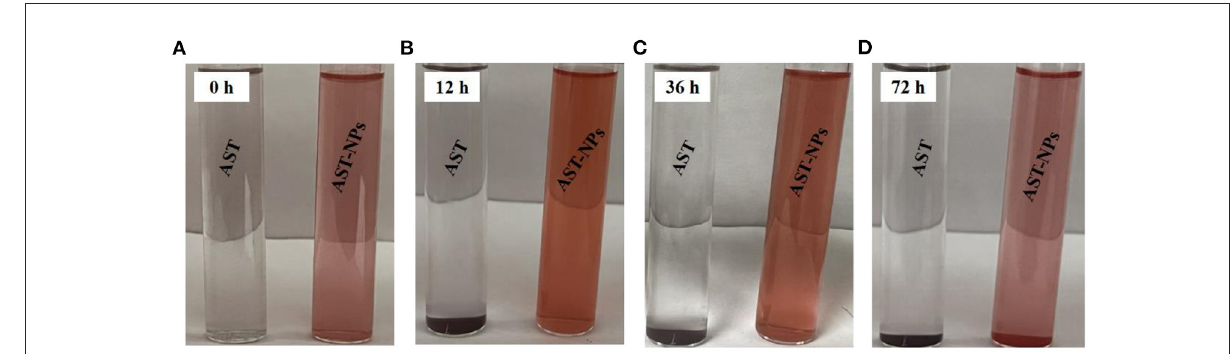
FIGURE5 The visual appearances of free AST and AST-NPs at 25 ◦ C at different time